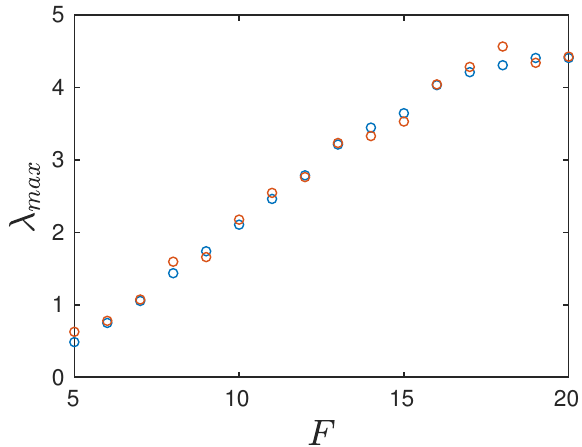
Figure 2. Maximum Lyapunov exponent of the Lorenz-96 model for different values of the forcing term F (blue dots). The integration time is T = 500 and N = 40. The red dots represent the exponents reported in Reference [28].